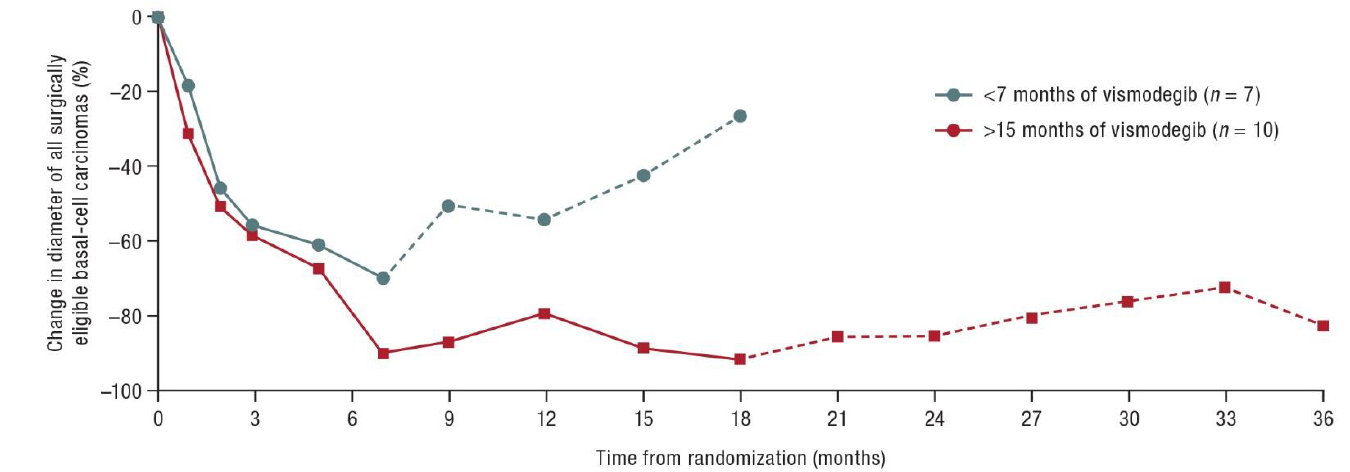
Figure 2. Median percent change in diameter of all surgically eligible BCCs. Solid lines represent time on vismodegib; dashed lines represent time off vismodegib. Modified according to [48].